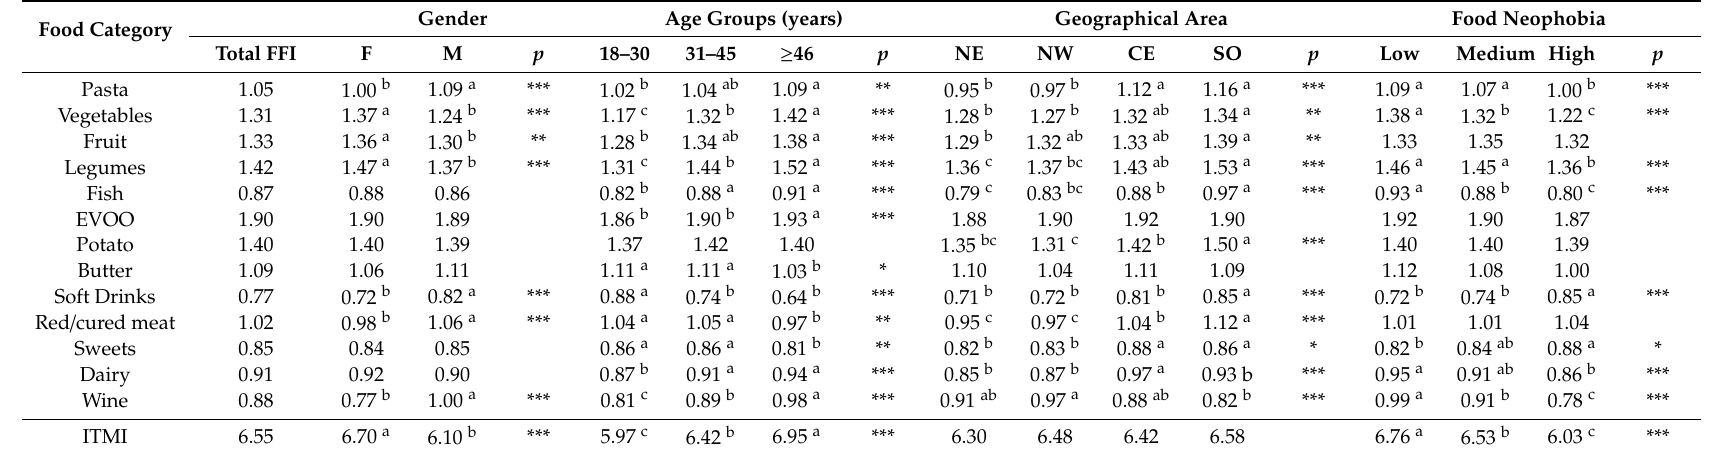
Table 4. Total Food Frequency Index (FFI, range 0–2) and FFI calculated for each food category by gender (F: females; M: males), age group, geographical area, food neophobia level, and derived Italian Taste Mediterranean Index (ITMI, range 0–13). Statistical di ff erences were determined for gender, age groups, geographical area (NE = North-East; NW = North-West; CE = Centre; SO = South and Islands), and food neophobia level (i.e., low, medium,